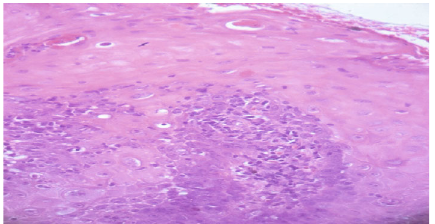
Figure 2: Histopathology of EM minor. A dermal in fl ammatory in fi ltrate consisting of lymphocytes, histiocytes, and necrotic epidermal